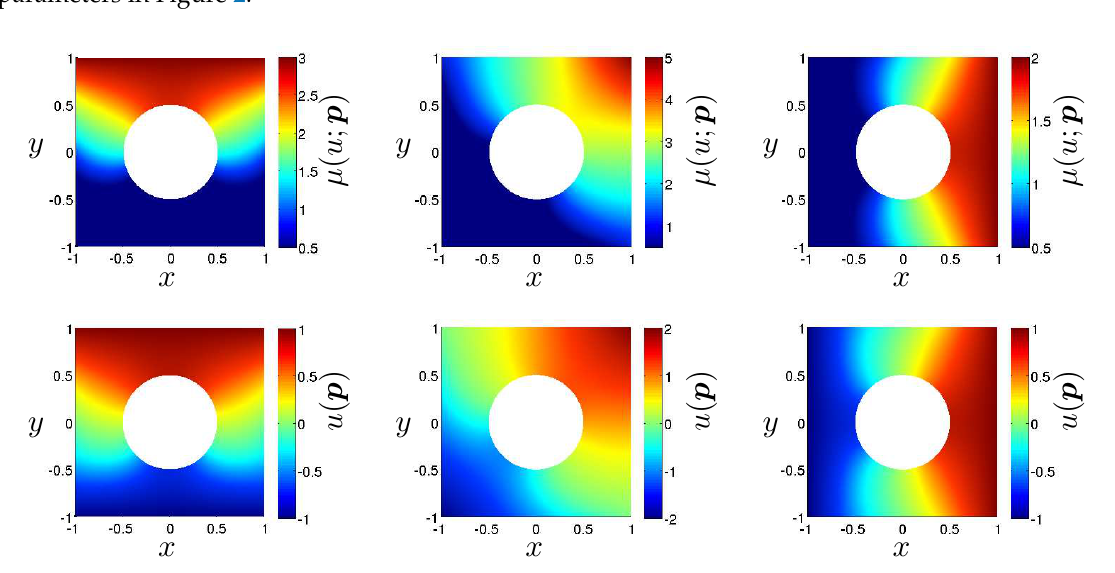
Figure 2. Parameter dependent conductivity µ ( u ; p ) (top row) and solution u ( x ; p ) (bottom row) for three different snapshot